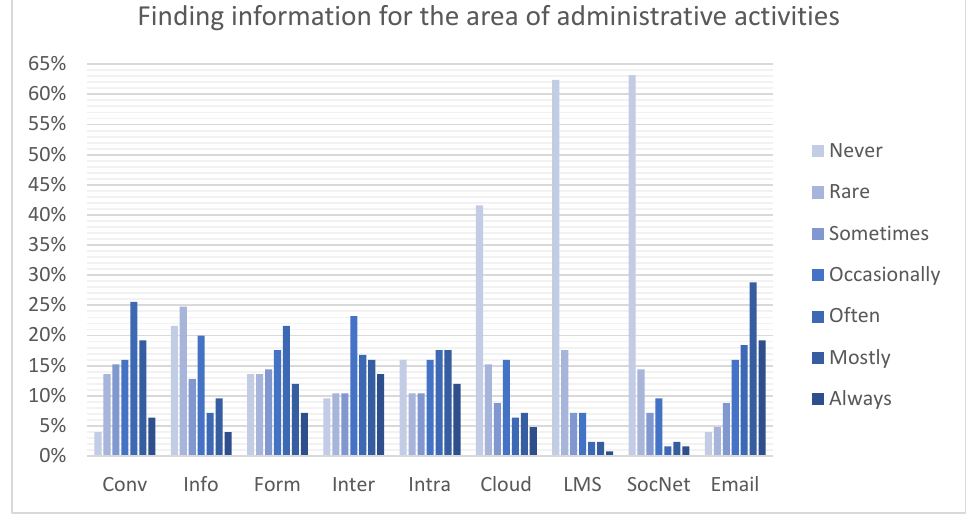
Figure 3. Ways of finding information in the area of administrative activities. (The complete legend is shown in Tables 1 and 2).